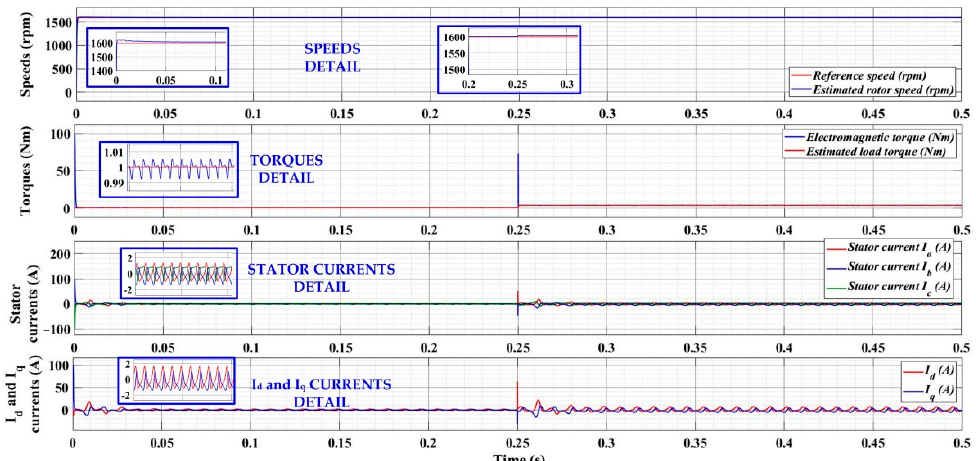
Figure 18. Time evolution for the numerical simulation of the PMSM control system based on the backstepping-PSO controller: ω ref = 1600 rpm, T L = 1 Nm → 4 Nm, K ω = 0.01, K I ω = 140, K q = 5000, K Iq = 50, γ = 0.01, K d = 300, and K id = 300.